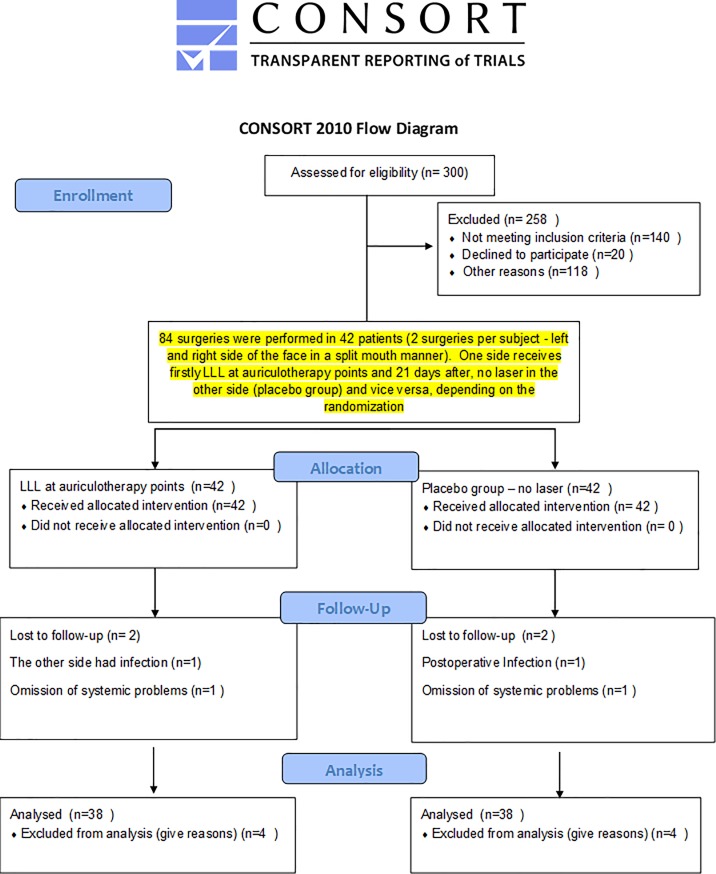
Activity flowchart.